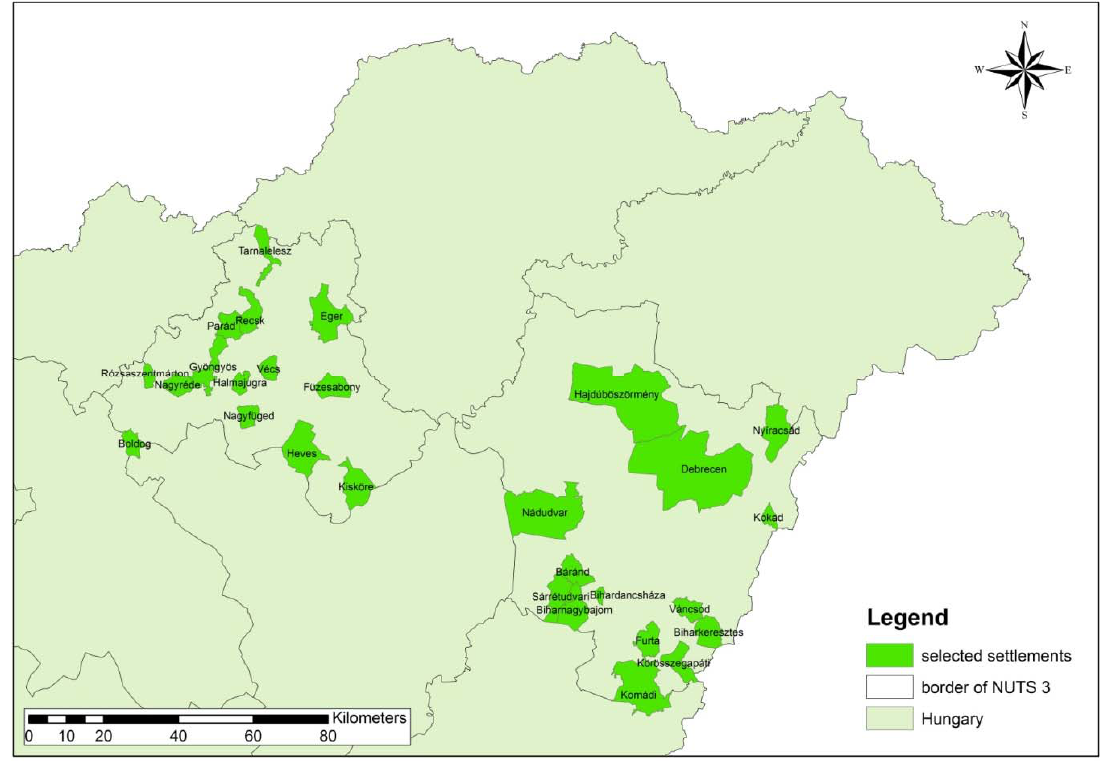
Figure 2. The geographic scope of the research (authors’ edition).